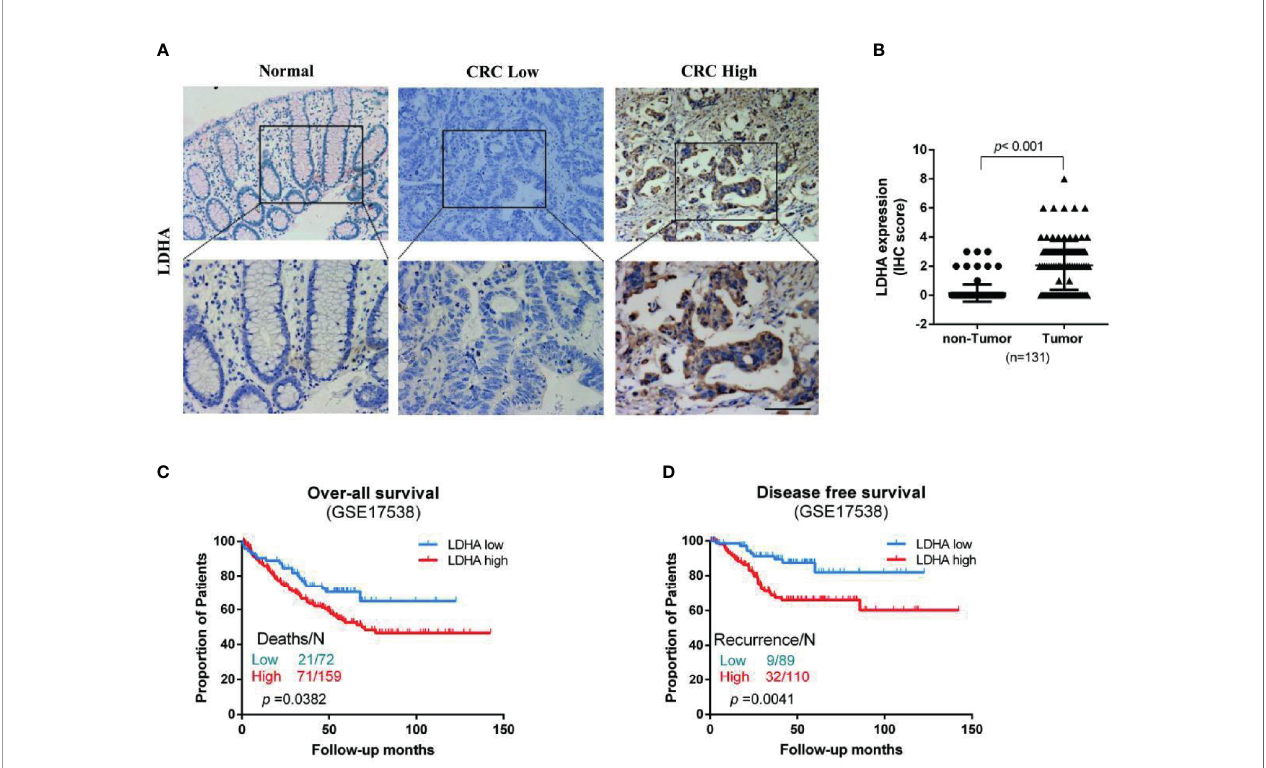
FIGURE 3 | LDHA expression in COAD tissues and its correlation with prognosis. (A) IHC staining shows the LDHA expression in normal or COAD patients (200×). The LDHA positive tissues are stained brown. (B) The expression of LDHA was higher in tumor tissues of COAD compared to adjacent tissues. (C, D) Kaplan-Meier analysis showing overall survival (OS) and disease-free survival (DFS) curves for COAD patients with different expression levels of LDHA; statistical signi fi cance was assessed by log-rank